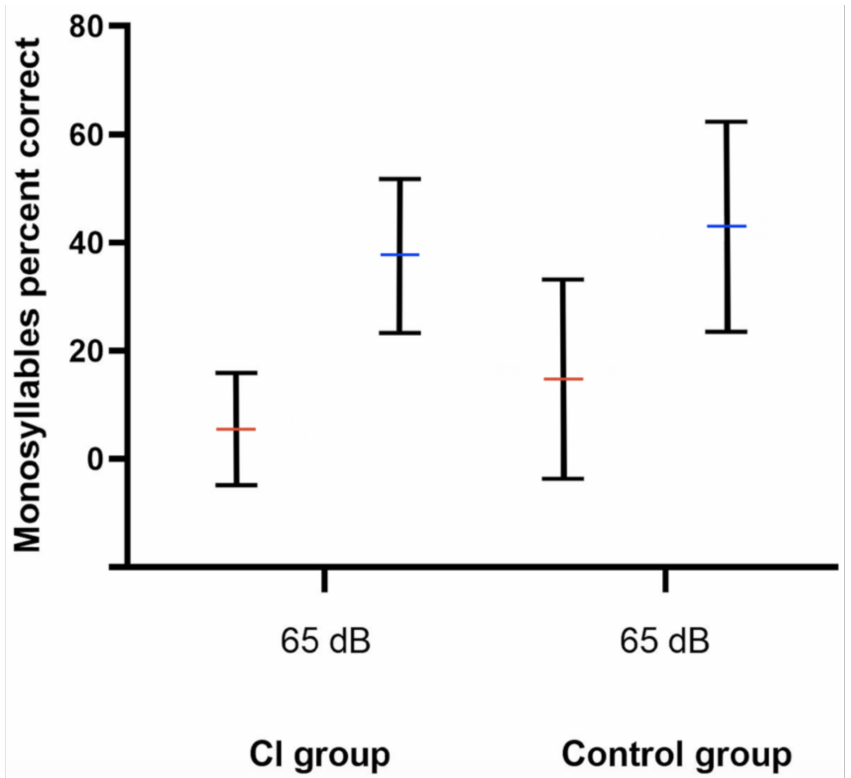
Figure 3. Speech recognition improvement at 65 dB SPL as measured by the Freiburger monosyllabic word test. Red and blue horizontal lines represent the mean unaided and VSB-aided speech recogni- tion, respectively. The whiskers depict the standard deviations. The CI group improved on average from 5.5 ± 10.4% to 37.5 ± 14.2% and the control group from 14.7 ± 18.4 to 42.9 ± 19.4% ( p = 0.461). dB; Decibel, SPL; sound pressure level, CI; cochlear implant, Control; control